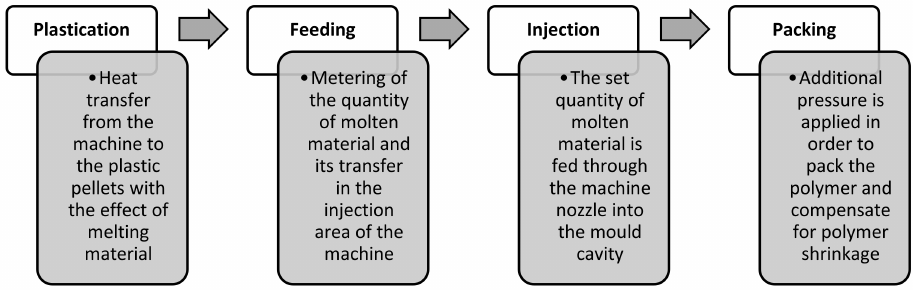
Figure 6. The phases of the moulding process performed by an injection moulding